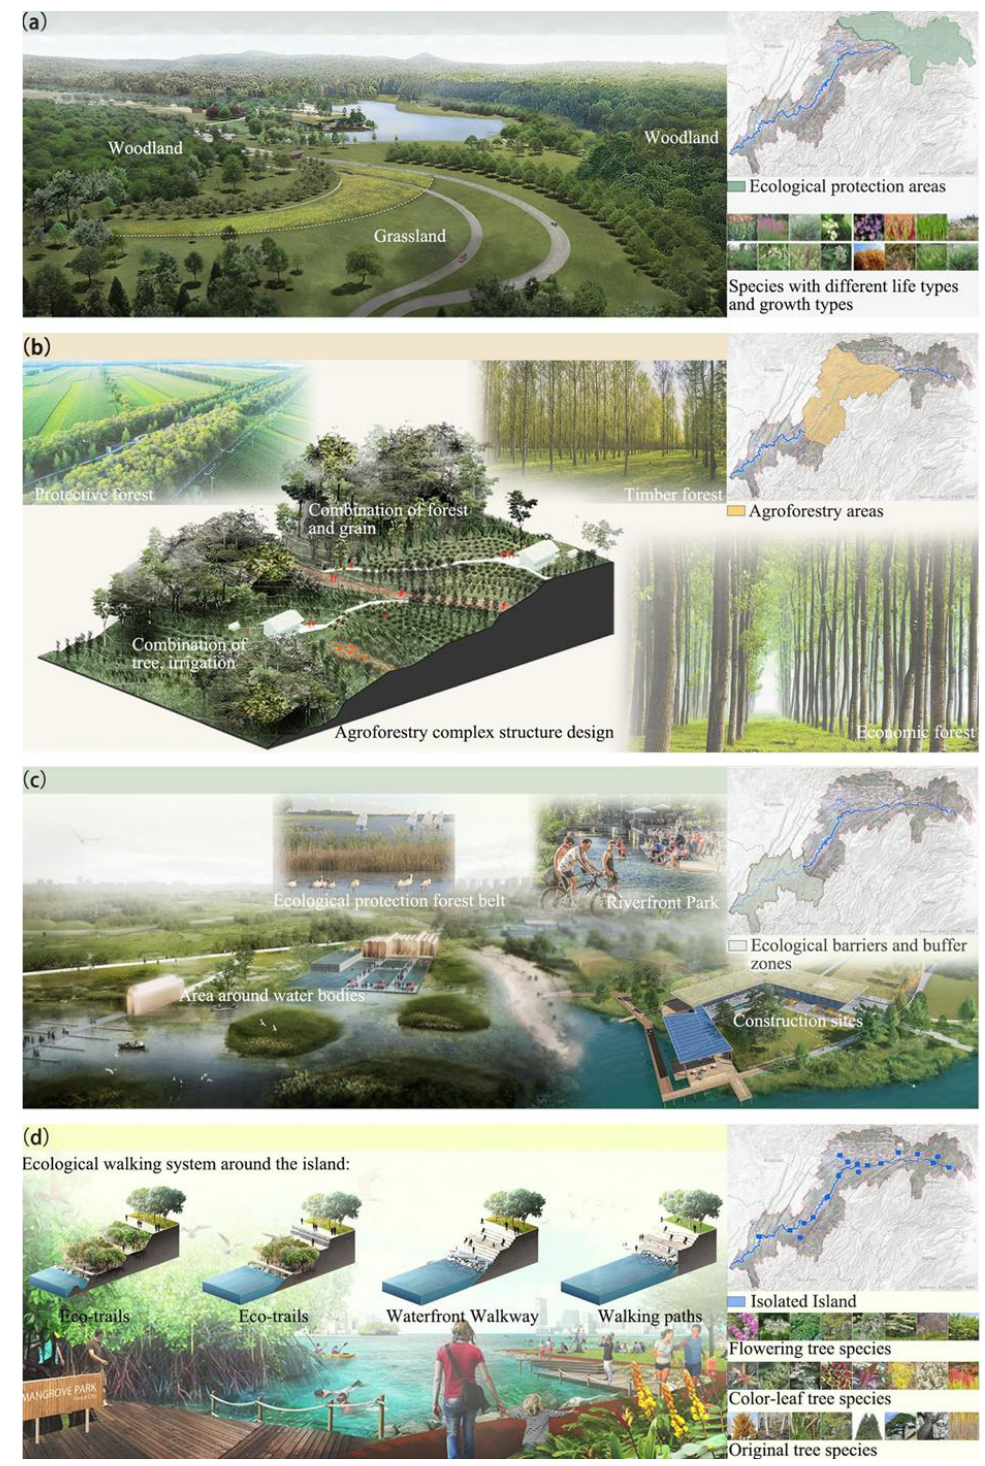
Figure 8. Landscape planning for ecological protection areas ( a ), agroforestry areas ( b ), ecological barriers and buffer zones ( c ), and large islands at high altitudes ( d ) to recover habitat quality. Agroforestry areas mainly refer to the middle of the TGR area and are covered by forests and crops (Figure 8b). Returning farmland to forests is the most important human activity in this region in the past few decades. However, monotonous crop and tree types are difficult to provide better habitat conditions [19]. We suggested